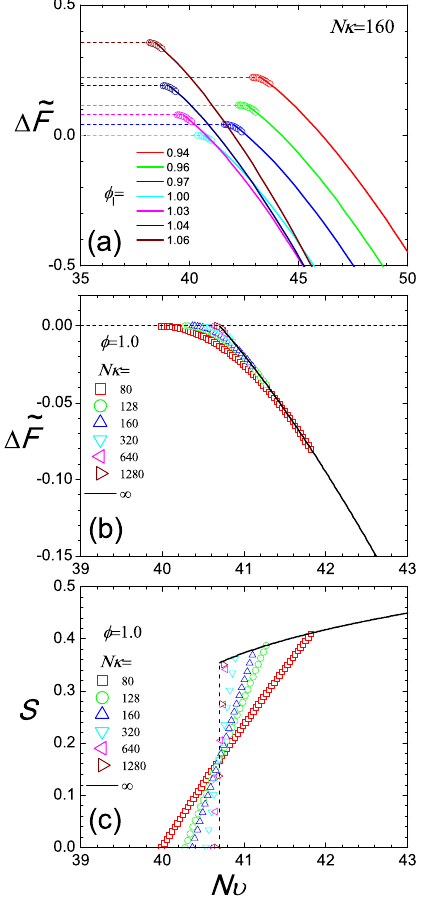
Figure 5. Two perspectives of the isotropic and nematic branches of the Helmholtz free energy difference plotted in ( a , b ) and the orientational order parameter in the coexistence regime ( c ). In Plot ( a ), we examine a system with N κ = 160; each set of data is plotted according to a specified volume fraction, φ = 0.94,0.96,0.97,1.00,1.03,1.04,1.06, where the isotropic branch is shown with a dashed line and the nematic branch with a solid curve. Circles represent the co-existence region where the free energy difference follows the tangent rule and connect the two branches. In Plots ( b , c ), we fix the total, averaged φ and observe the two free energy branches (again dashed and solid curves for isotropic and nematic states, respectively) and S as functions of the temperature-like parameter N υ . The free energy difference and S in the coexistence region are calculated from the mixing rule and plotted by symbols as a function of N υ , for various degrees of compressibility N κ = 80 (square), 128 (circle), 160 (up-triangle), 320 (down-triangle), 640 (left-triangle), 1280 (right-triangle), ∞ (solid